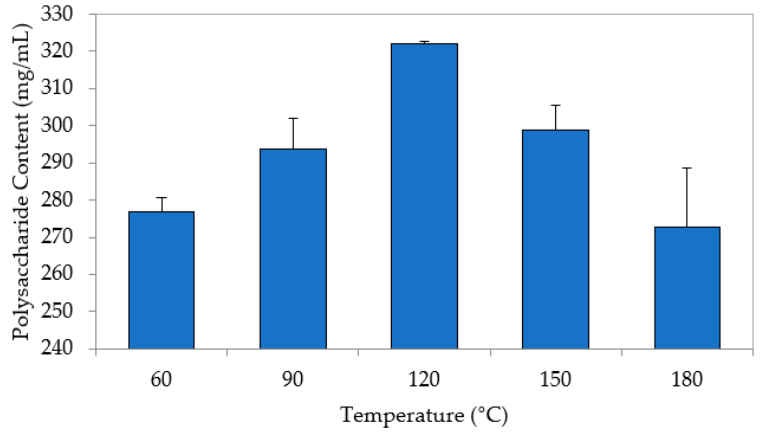
Figure 2. Polysaccharide extraction at different temperatures.